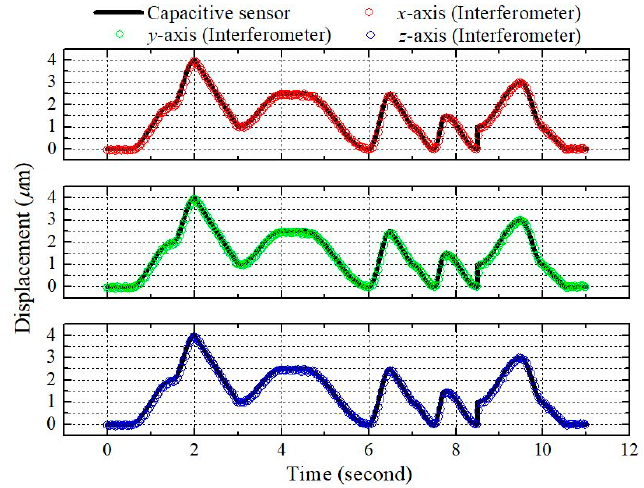
Figure 6. Measurement results for random displacement.